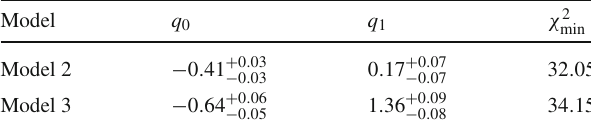
Fig. 5 The evolution of j ( z ) with respect to redshift z is shown using the best-fit values of q 0 and q 1 for different values of N , as indicated in the frame . The horizontal thick line ( magenta ) indicates j = 1 (con- stant) for a (cid:5) CDM model Table 2 Results of statistical analysis (within 1 σ confidence level) for Model 2 and 3 by considering SNIa + BAO/CMB dataset Model